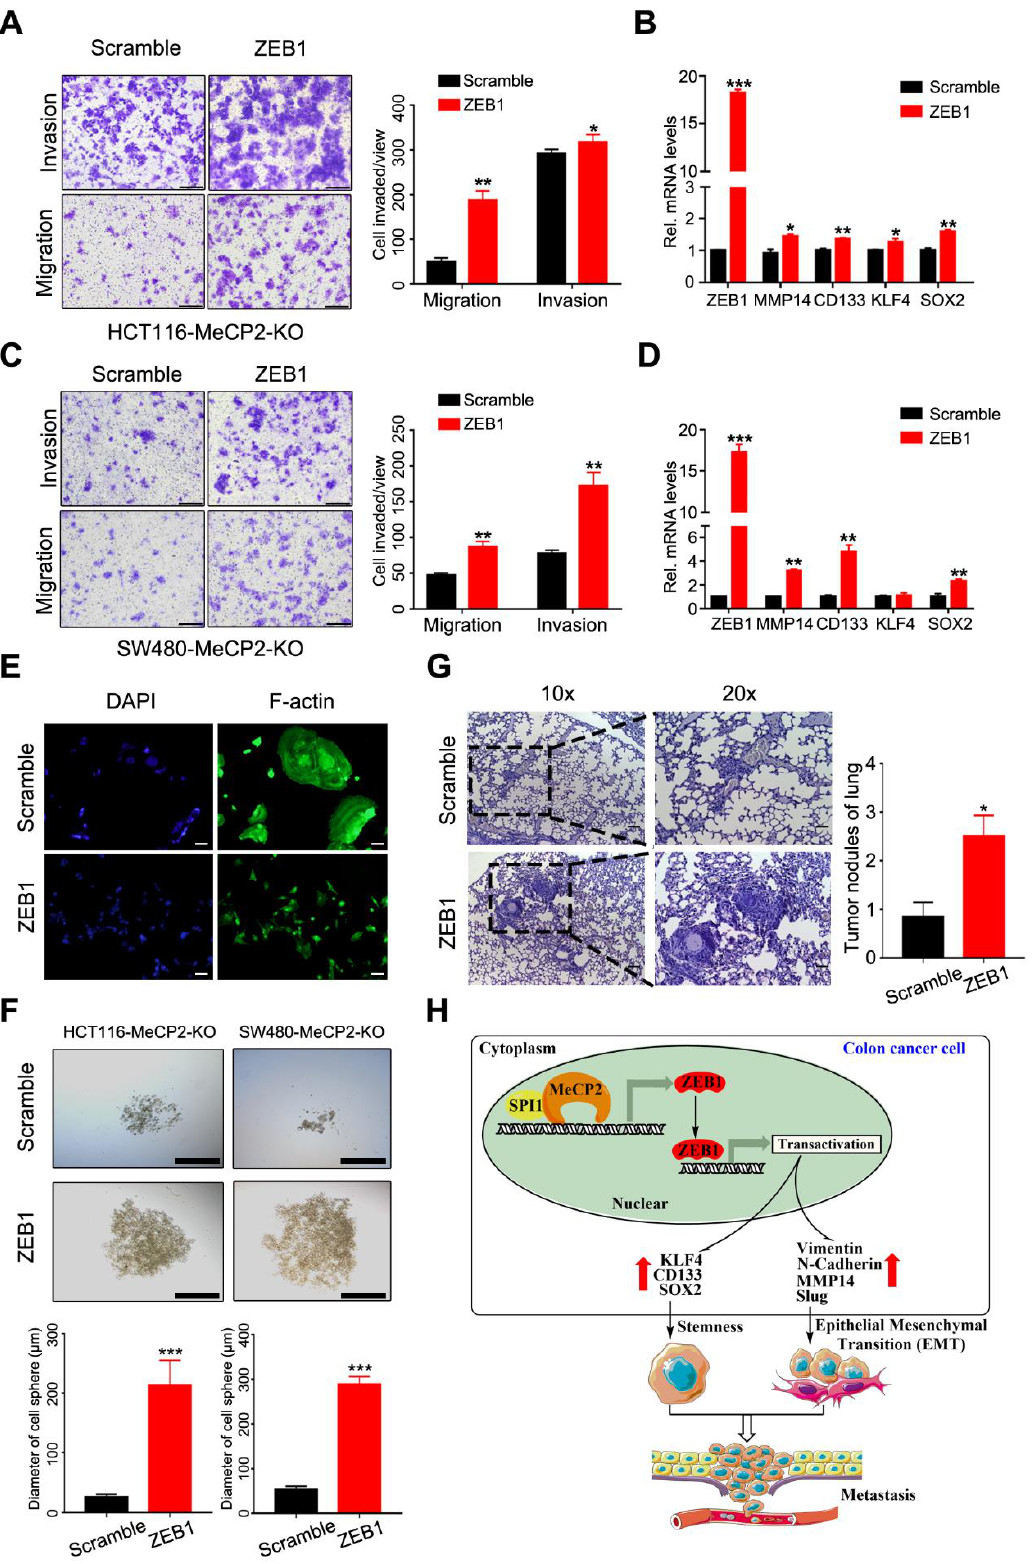
Figure 7. ZEB1 restores the migration, invasion, and metastasis of colorectal cancer cells, and was abrogated by MeCP2 depletion. ( A ) The migration and invasion ability of MeCP2-depleted HCT116 cells was rescued by ZEB1. ( B ) After MeCP2-depleted HCT116 cells were rescued with Scramble or ZEB1, the mRNA levels of ZEB1 , MMP14 , CD133 , KLF4 , and SOX2 were examined. ( C ) The migration and invasion ability of MeCP2-depleted SW480 cells was rescued by ZEB1. D After MeCP2-depleted